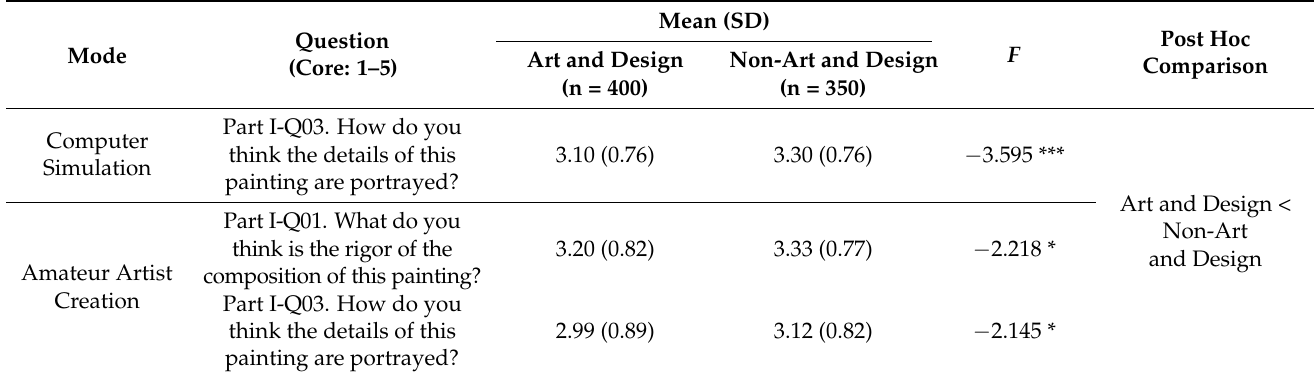
Table 7. The cognitive differences between audiences of different